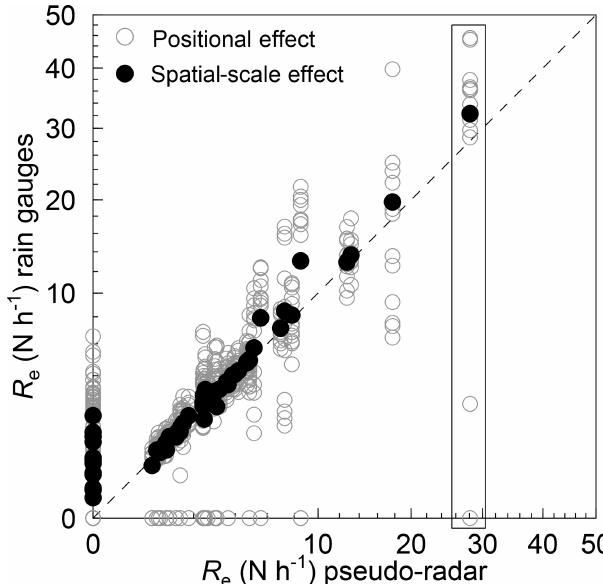
Figure 6. Event erosivity R e at 12 rain gauges located within a 1km 2 pixel vs. R e based on pseudo-radar data calculated from the hyetographs of the 12 rain gauges (open grey circles). Filled black circles show the average R e of all 12 rain gauges vs. the R e from pseudo-radar rainfall. Note that the average R e can be consider- ably larger than zero while the averaged rainfall of the pseudo-radar remains below the thresholds of erosivity (black circles along the y axis). Rectangular frame shows variation of R e for a single day. Axes are square-root-scaled to improve resolution at low R e